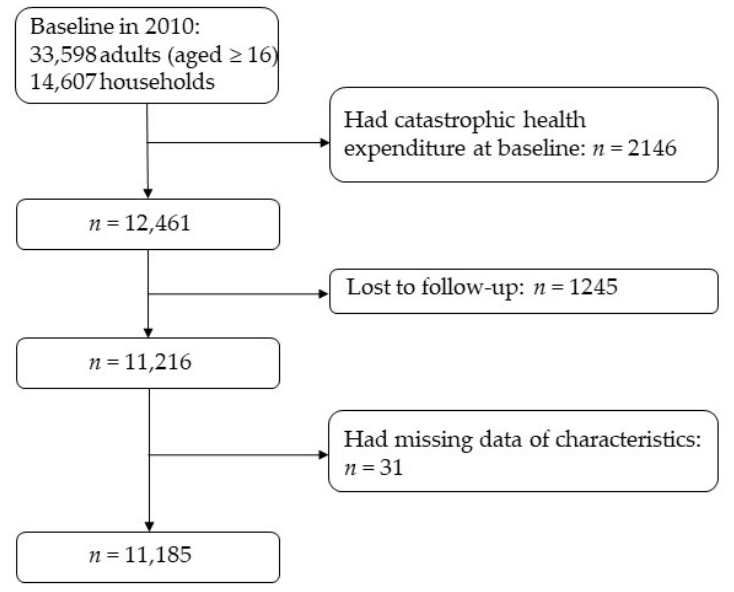
Figure 1. Flowchart of the study population.